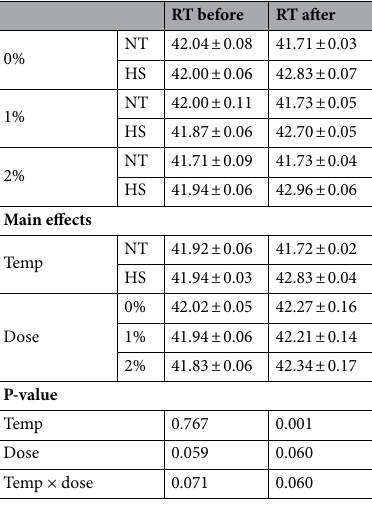
Table 2. Effect of dietary steam-exploded pine particle supplementation on the rectal temperatures (°C) of broilers reared under normal or cyclic heat stress conditions. RT rectal temperature, NT thermoneutral temperature, HS heat stress. Values are presented as mean with standard error (n = 6).